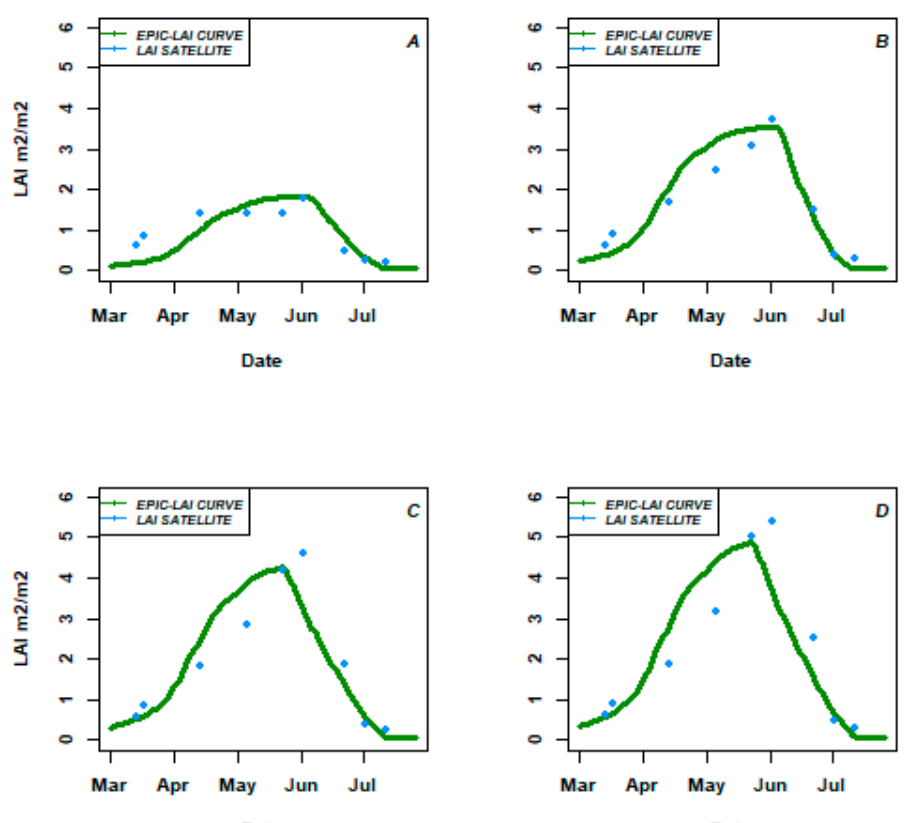
Figure 4. Calibration: the graphs show the di ff erent LAI values in four plots for 2016 for di ff erent levels of fertilization: 0 kg N / ha ( A , id: 1-1), 60 kg N / ha ( B , id: 2-1), 120 kg N / ha ( C , id: 3-1), and 180 kg N / ha ( D , id: 4-1). The green line is the daily LAI curve obtained by EPIC model, while the light blue points are the LAI measurements obtained using Sentinel-2 data.